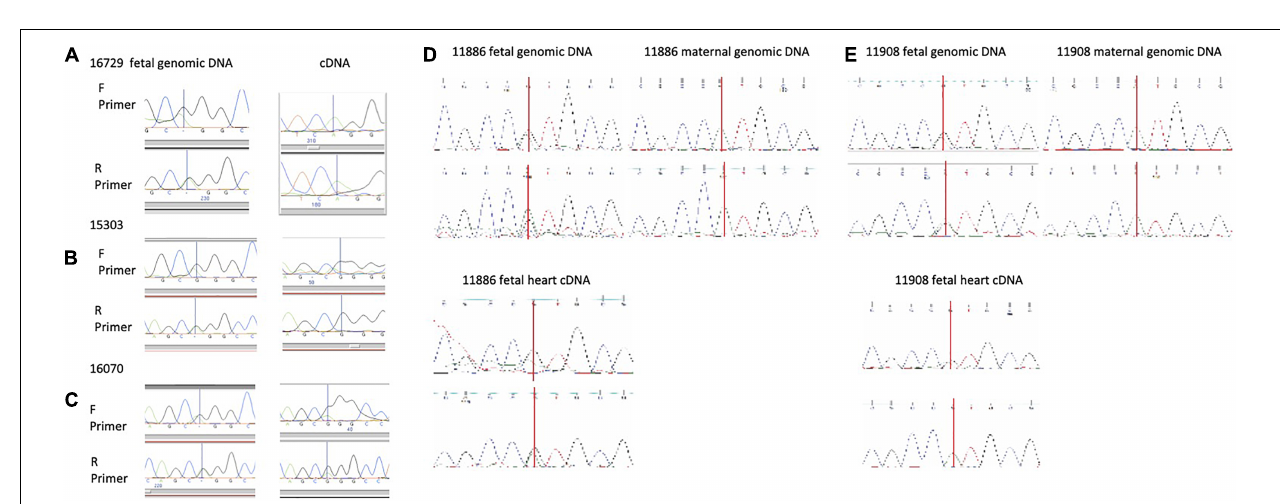
FIGURE 4 | (A,B) Human fetal heart allele-specific assays, informative samples from 25 hearts collected from a tissue bank. Individuals in (A,B) are mono allelic (one peak across the SNP) and the individual in (C) presented with a biallelic pattern of expression (2 peaks across the SNP). SNPs annotated in the UCSC genome browser were identified in these individuals by sequencing genomic (g)DNA in the forward (F) and reverse (R) directions but allelic origin could not be assigned without parental samples. The SNP is indicated by a vertical line. (D,E) Human fetal heart allele-specific assays, informative samples from 15 individual hearts with both fetal and maternal DNA samples. SNPs annotated in the UCSC genome browser were identified by sequencing with flanking primers in gDNA from the mother (single peak) and fetus (double peak) in the upper panels. Allele-specific assays amplifying and sequencing cDNA from fetal heart RNA are in the lower panels. Sample 11,886 has both peaks indicating expression from the maternal and paternal alleles whereas mono-allelic paternal expression of DDC_EXON1A is detected in 11,908.